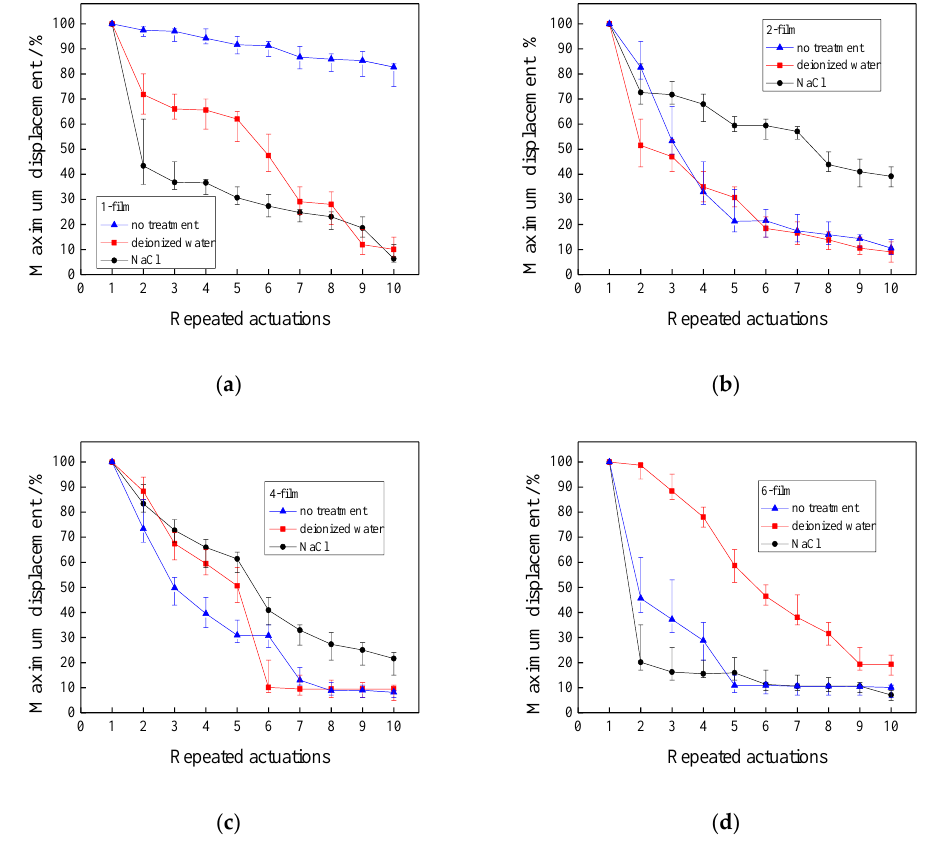
Figure 10. Maximum displacements when the IPMCs with various thicknesses are repeatedly actuated. ( a ) 1-film; ( b ) 2-film; ( c ) 4-film; ( d )